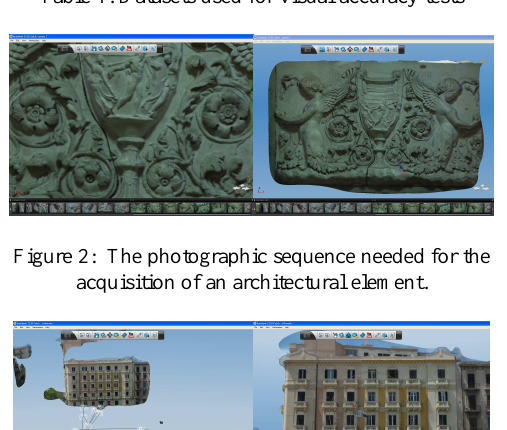
Table 1. Datasets used for visual accuracy tests